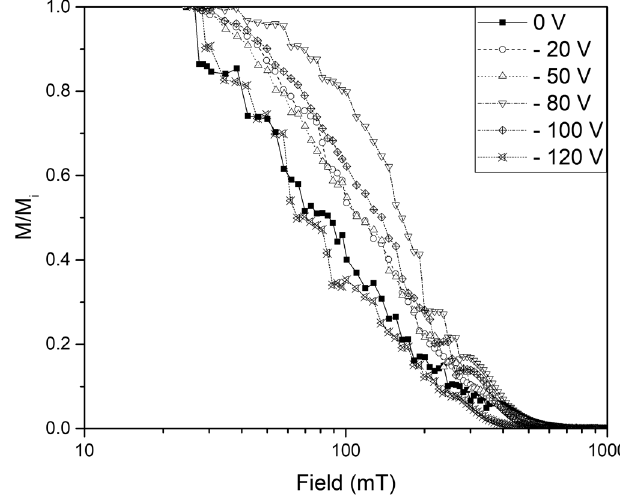
Þ for FIG. 7. The normalized dc hysteresis curves for samples max deposited at 500 °C with substrate bias of 0 to − 120